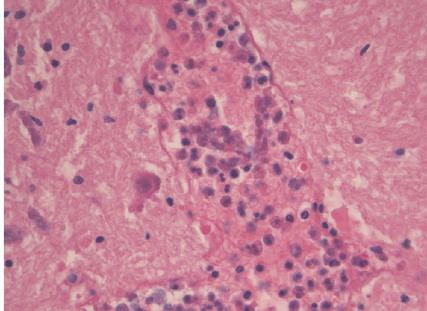
Figure 3: A cerebral vein completely obliterated by normally non- circulating bone marrow components (promyelocytes and myelo- cytes) (H & E, ∗ 40).